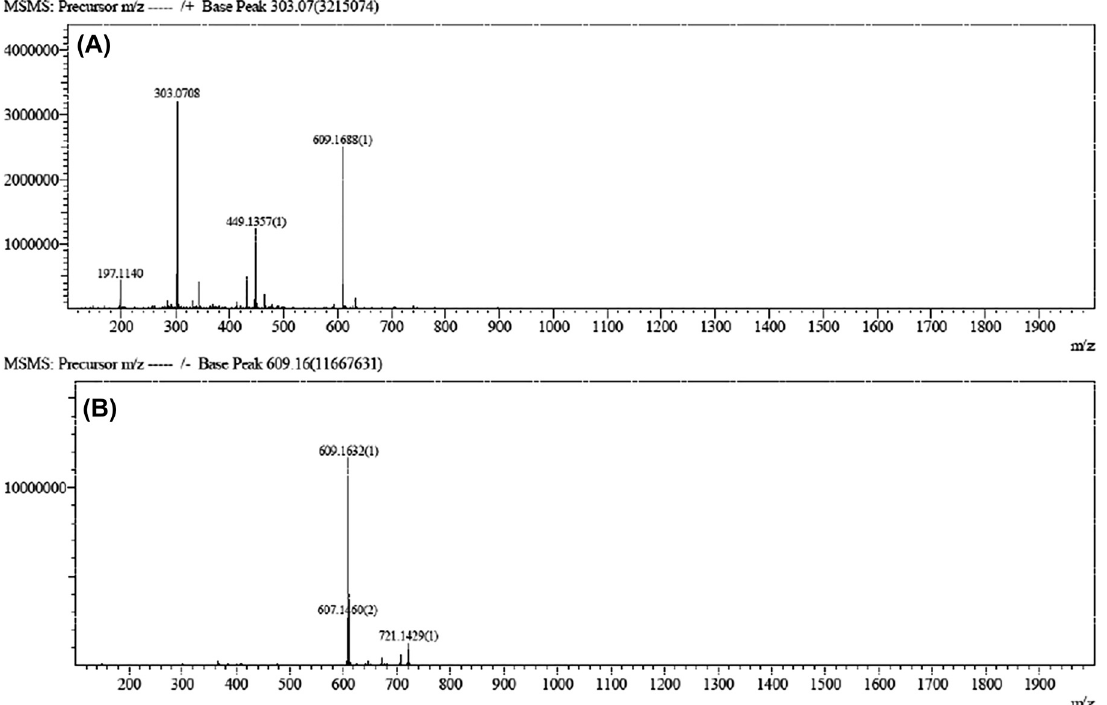
Figure 3: Mass spectrometry spectrum of the ethyl acetate extract of C. hystrix . (A) Quercetin, (B)